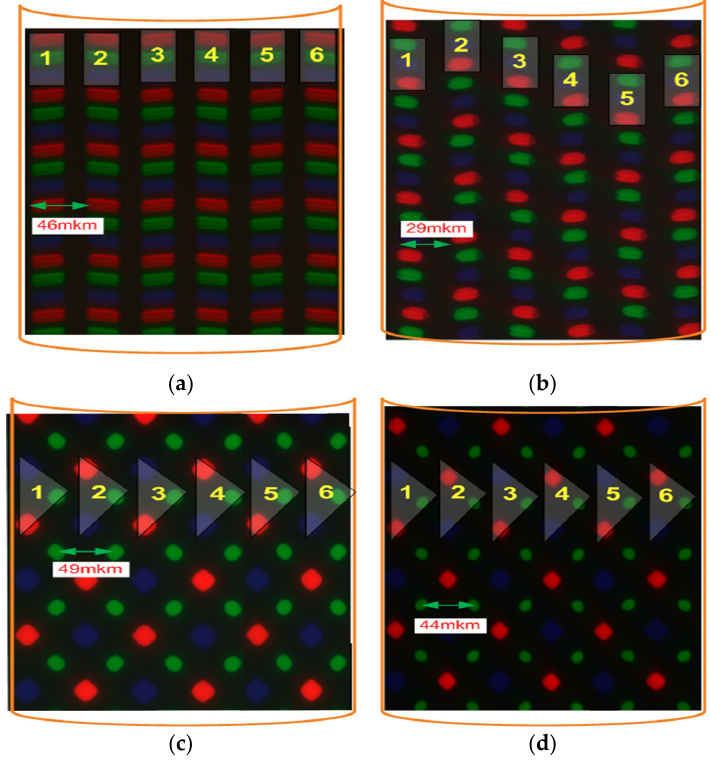
Figure 11. Images of pixel structures: ( a ) LG G3—IPS; ( b ) 4K Sony Xperia—IPS; ( c ) Samsung Galaxy Note 4—diamond pixel structure; ( d ) Samsung Galaxy S7—diamond pixel structure. Numbers from 1 to 6 correspond to the view numbers.